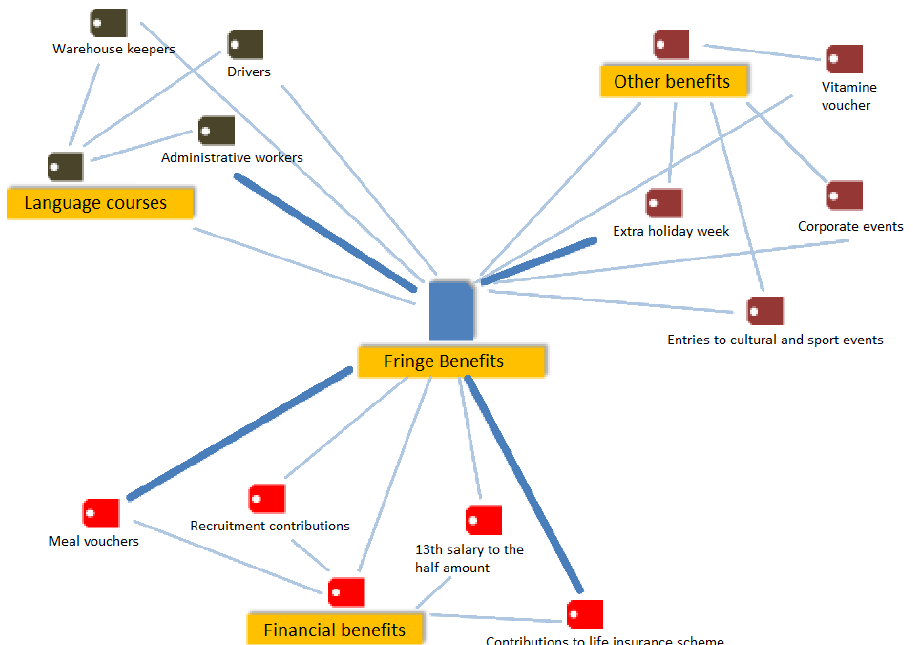
Figure 4. Map of the current benefits in the company. Source: authors.